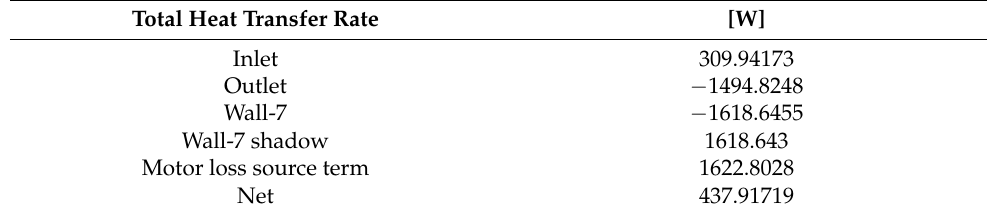
Table 4. Overall motor losses from axial water